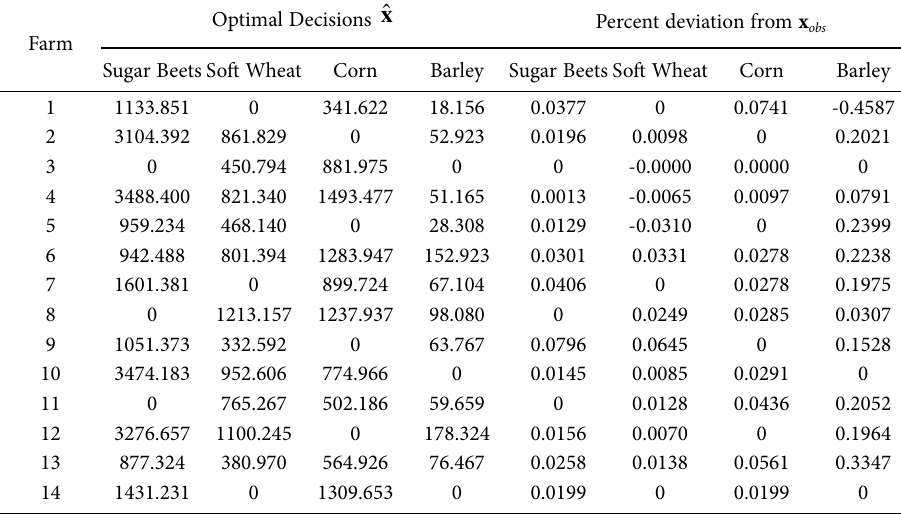
Table 5. Estimated LS solution, ˆ x , and percent deviation from the observed levels, x obs with zero lev- els for some crops and some farms.